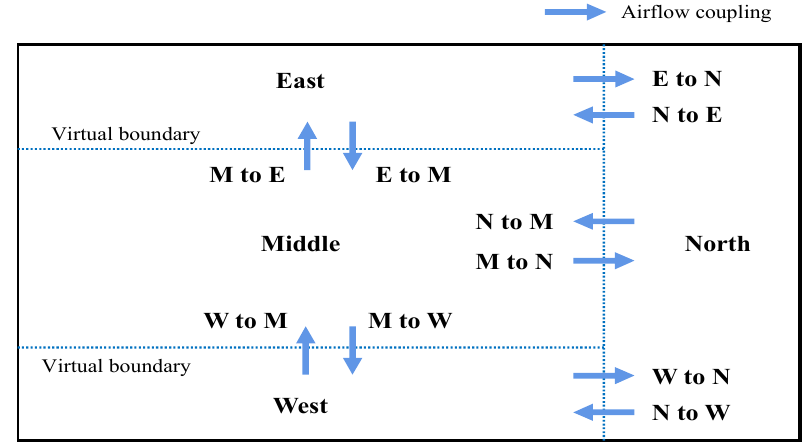
Figure 11. TRNSYS-CONTAM joint control platform.